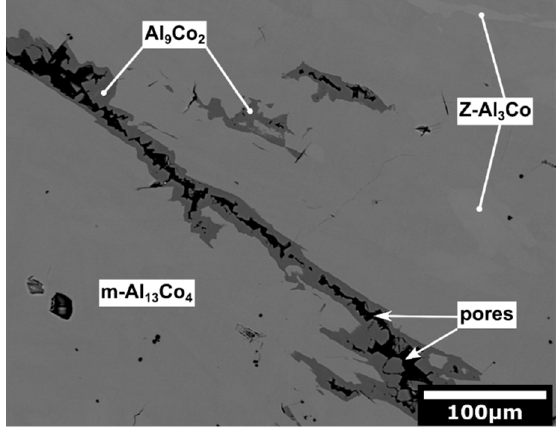
Figure 3. Microstructure of the as-solidified Al 76 Co 24 alloy.